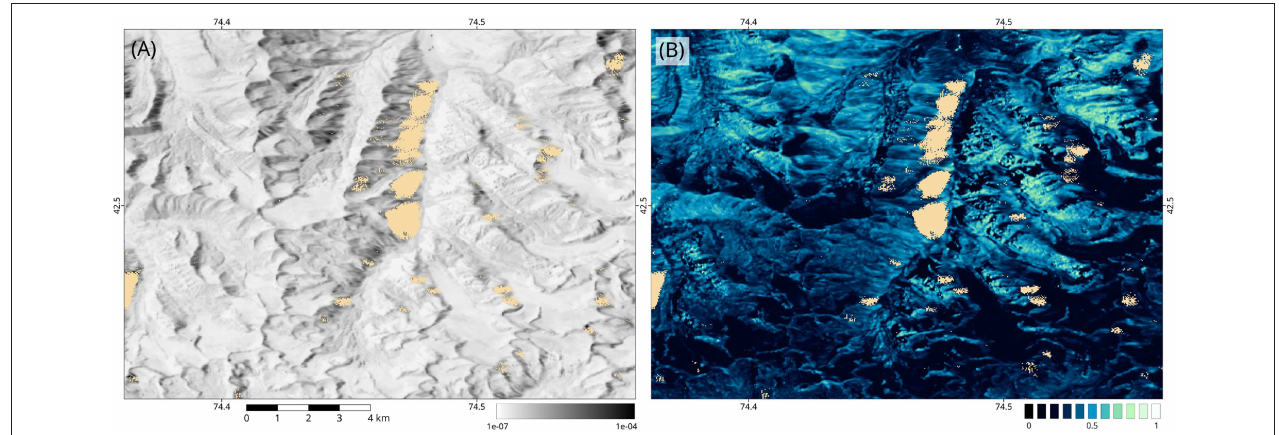
FIGURE 4 | Average (A) amplitude and (B) coherence values for the full time series ( n = 54) and the core study area in the Ala Archa mountain range (cf. Figure 2 ). Beige color indicates locations where at least one result had “no data” values. Contains modified Copernicus Sentinel data